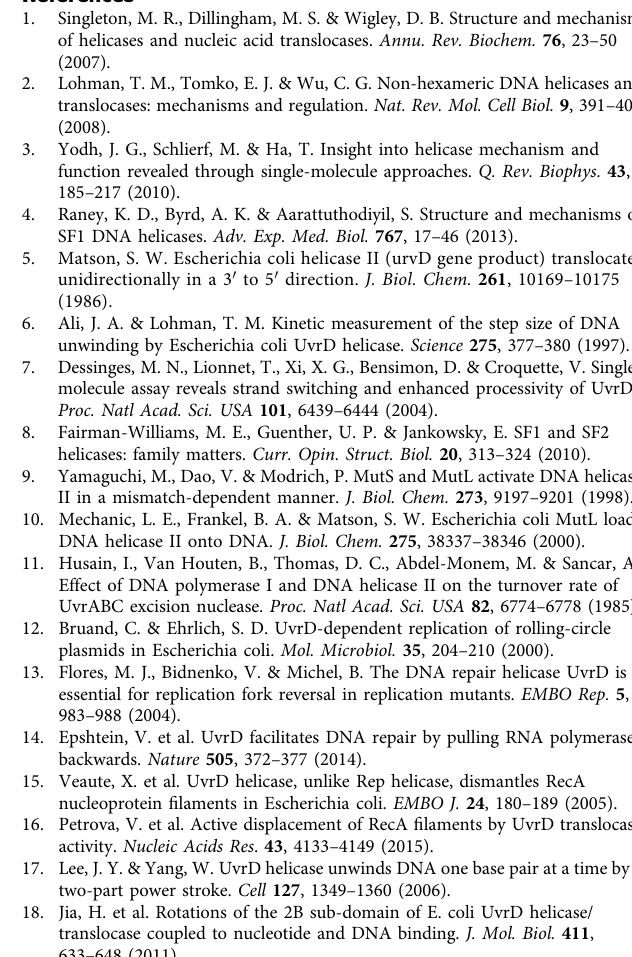
Fig. 3b. As a standard practice, we applied the Generalized Born model 63 to evaluate the interaction strength between the ssDNA nucleotides and protein residues for the simulated conformations. The interaction energy Δ E between a ssDNA nucleotide and a protein residue is calculated according to Δ E = E − E − E complex nucleotide protein , where E x is the total electrostatic and Van der Waals energy including the GB solvation energy for system x. A 16-Å cutoff was used for the GB model, the ion concentration was set to 55mM, and a dielectric constant of 80 for the solvent was used. The structural images were rendered with VMD 64 . To align the helicase motor domains, we used the MultiSeq program 65 in VMD with default values. The 1A and 2A domains of exemplary SF1 and SF2 helicases were aligned to the corresponding UvrD motor domains separately. The default similarity table in the Boxshade program was used for coloring the residues in Fig.